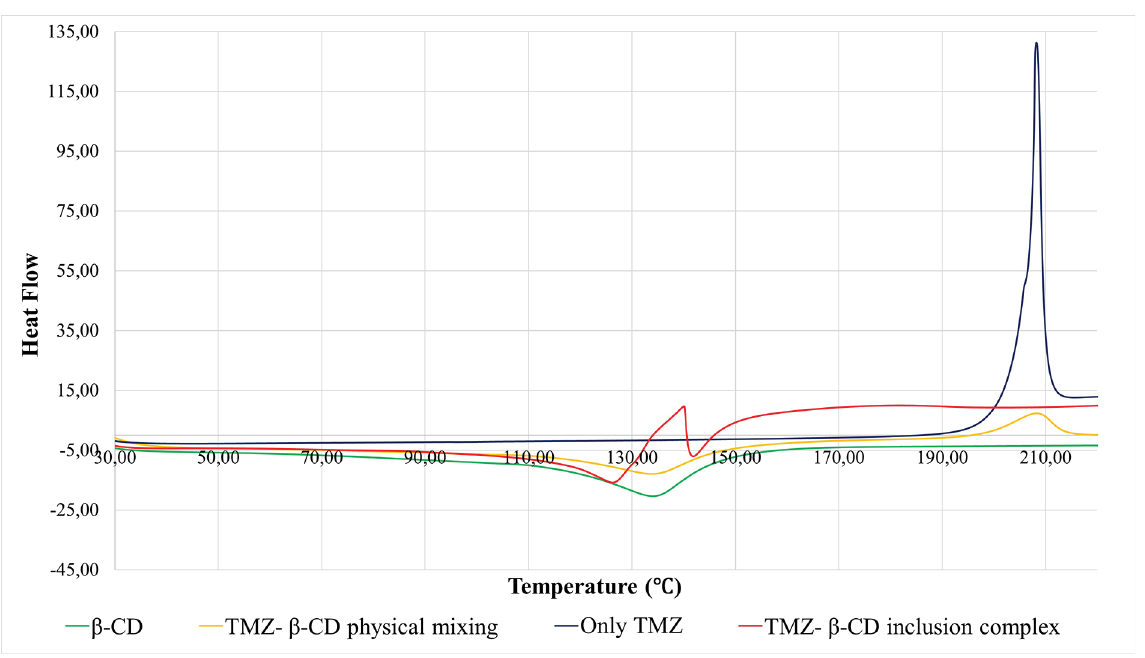
FIGURE 7 - DSC curves of TMZ- β -CD inclusion complex and physical